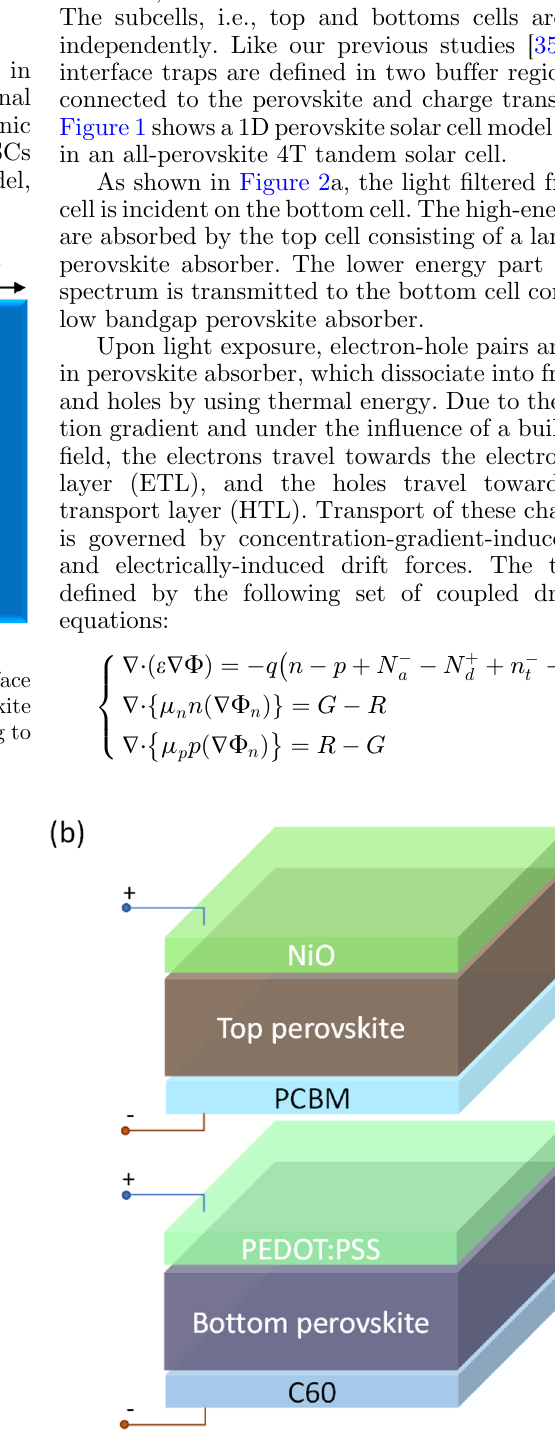
Fig. 2. (a) Spectrum splitting in a tandem solar cell, and (b) all-perovskite four-terminal (4T) tandem solar cell representation. The material layers in (b) correspond to the materials used in this